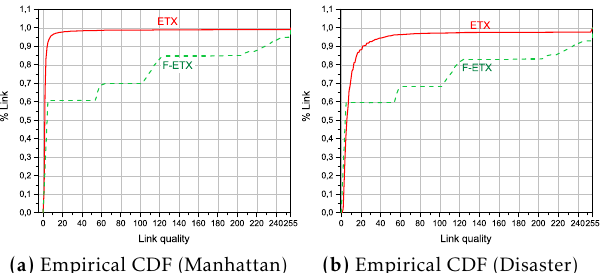
Figure 8. ETX vs F-ETX :